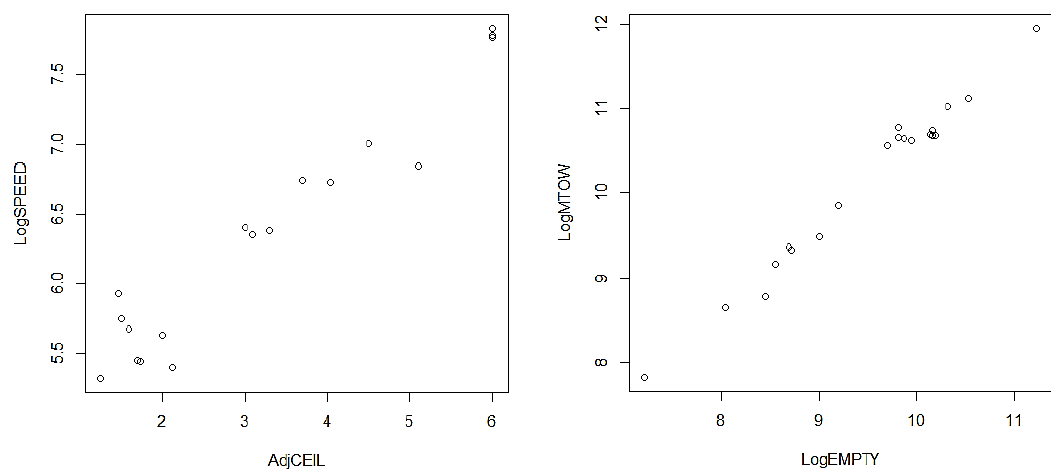
Figure 5. Visualization of the existing strong linear relationships between LogSPEED ~ AdjCEIL and LogMTOW ~ LogEMPTY.